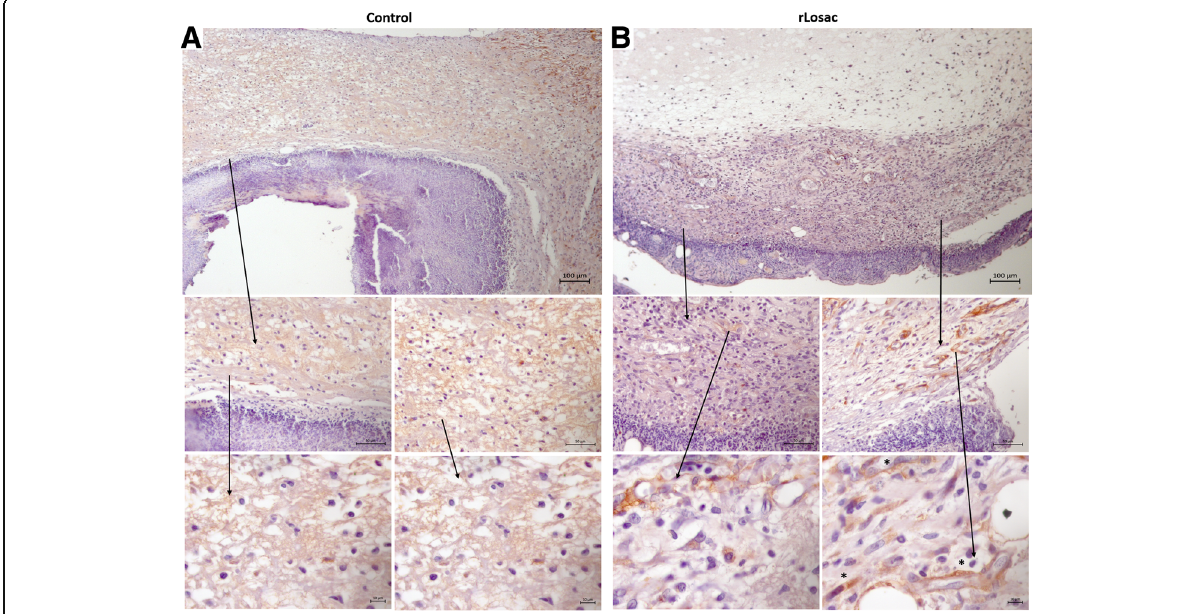
Fig. 5 Assessment of scar tissue by immunohistochemistry – collagen type I from the group treated during the experiment period. Micrographies of scar tissue evaluated after day 3 ( a control group; b treated group). All areas are shown at magnifications of 100, 40 and